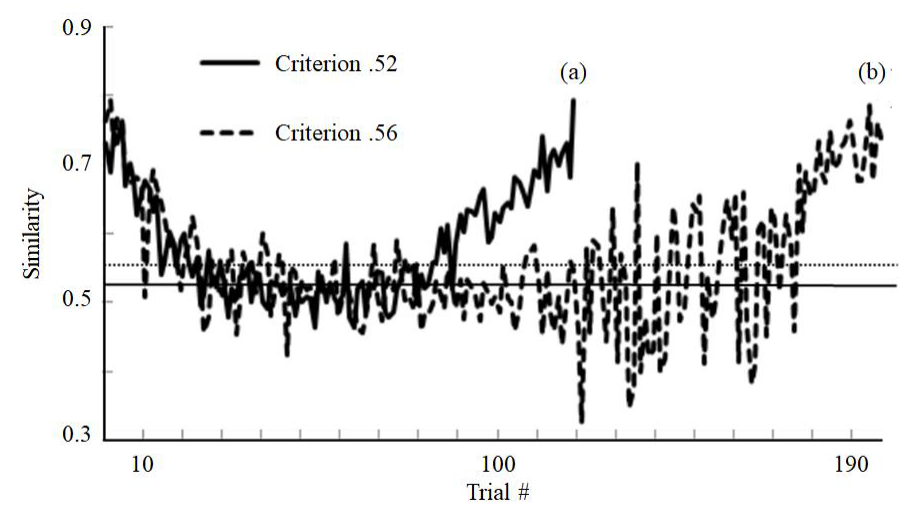
Figure 1. Example U-curves of similarity index between vocalization and playback sound in two sessions of Experiment 3 (Subject; Eros). (a) With lower criterion, the bird could pass the bottom of the curve at easy with production of either vocal-A or B. (b) With higher criterion, the bird began to struggle around the bottom of the curve. In such condition, the bird vocalized novel patterns with moving around in the cage.